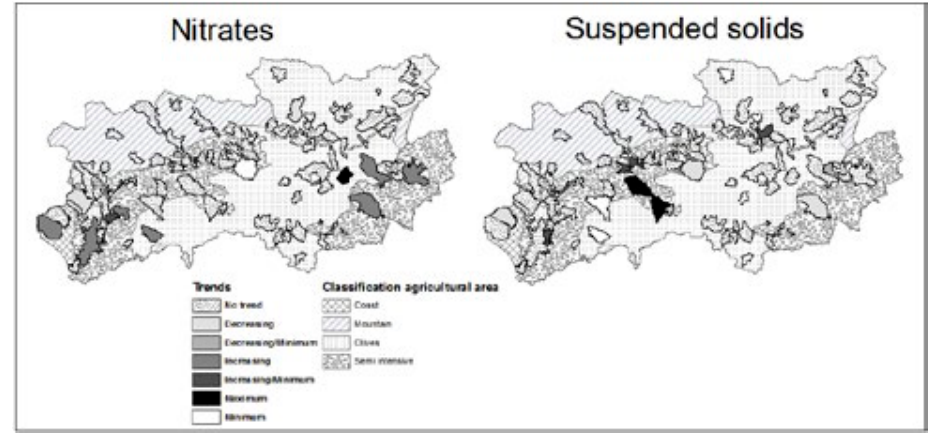
Figure 3. Linear and quadratic trend regressions with significant coefficients (p<0.05) for median annual values of concentrations of nitrates and suspended solids. The linear trend provides the slope ( b) of the time variable ( H) , with y t = a + bH t + ε t , where y t is the concentration of either nitrates or sus- pended solids, H t is the time trend ( t=1,...,T ) and ε t is the error term. The quadratic trend equation y t = a + bH t + cH t 2 + ε t is used to check for convex or concave trend behaviour. The classification of dominant agricultural areas across the basin is also